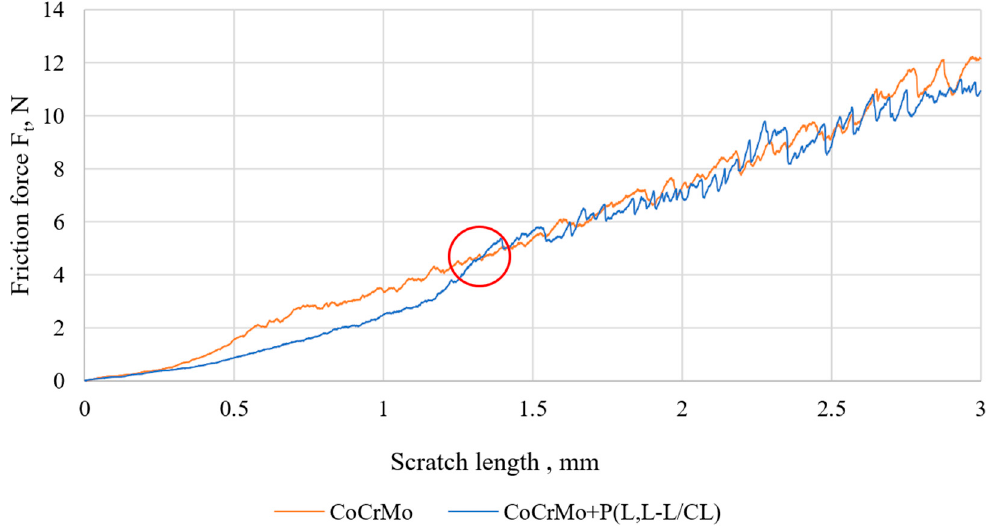
Figure 4. An exemplary graph of the friction force as a function of the scratch length of uncoated and P(L,L-L/CL) coated samples. Table 2. Summary of test results for the adhesion of P(L,L-L/CL) and P (D,L-L/CL) coatings to the substrate.